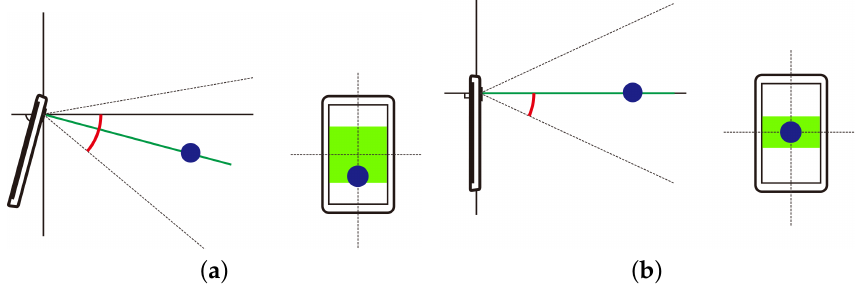
Figure 7. ( a ) Normally measured activity angle. ( b ) Activity angle before error